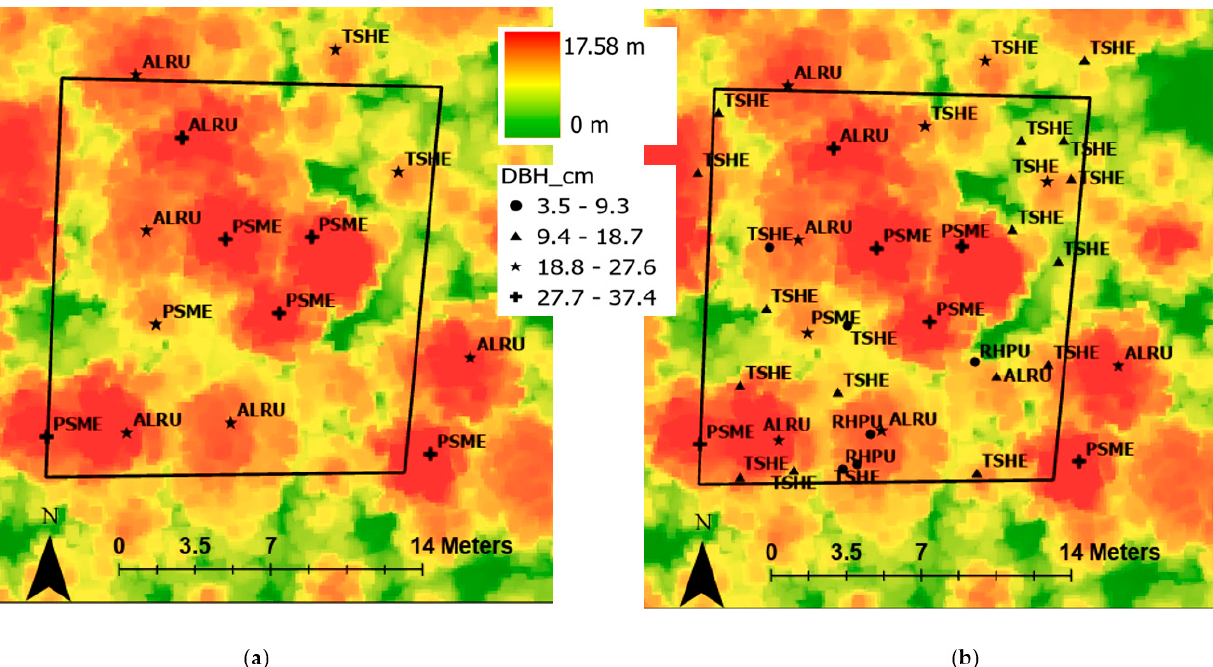
Figure 2. Matching of stem maps and light detection and ranging (LiDAR) canopy height models (CHMs) for an example tree plot. Individual trees are represented as different symbols based on their diameter at breast height (DBH; cm) and labeled based on their USDA species code (ALRU is red alder ( Alnus rubra Bong.), PSME is Douglas fir ( Pseudotsuga menziesii Mirb Franco), TSHE is western hemlock ( Tsuga heterophylla (Raf.) Sarg.), and RHPU is cascara ( Rhamnus purshiana (DC.) A. Gray)). The tree plot corners and borders are also shown. ( a ) Depicts the plot with only the larger trees, DBH 20 cm and higher, matched to the CHM; ( b ) depicts the same plot as ( a ) but with all